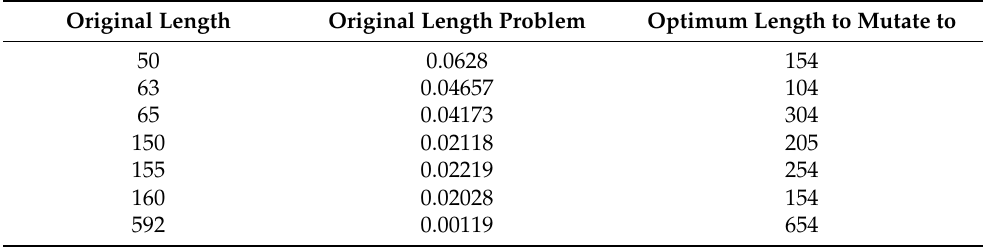
Table 9. Sample of length mapping of Viber app, using OPriv.